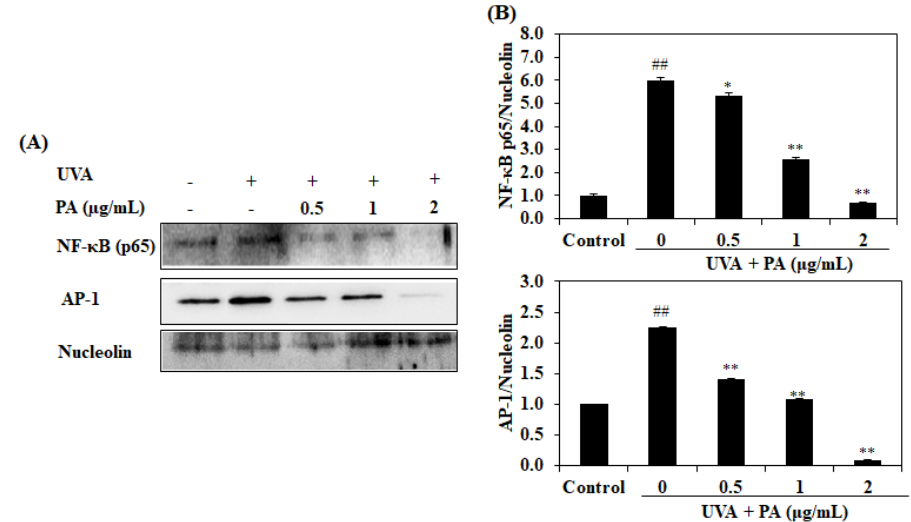
Figure 6. PA inhibits NF- κ B activation and AP-1 phosphorylation in UVA-irradiated HDF cells. The inhibitory effects of PA on UVA-irradiated nuclear NF- κ B protein expression and AP-1 phosphorylation ( A ) and relative NF- κ B expression and AP-1 phosphorylation levels ( B ). The relative NF- κ B expression and AP-1 phosphorylation levels were compared with those of nucleolin. The values are expressed as the mean ± SD in triplicate experiments. ## p <0.01 indicates a significant difference compared to the control groups. *p < 0.05 and **p < 0.01 indicate a significant difference compared to the only UVA-irradiated groups.